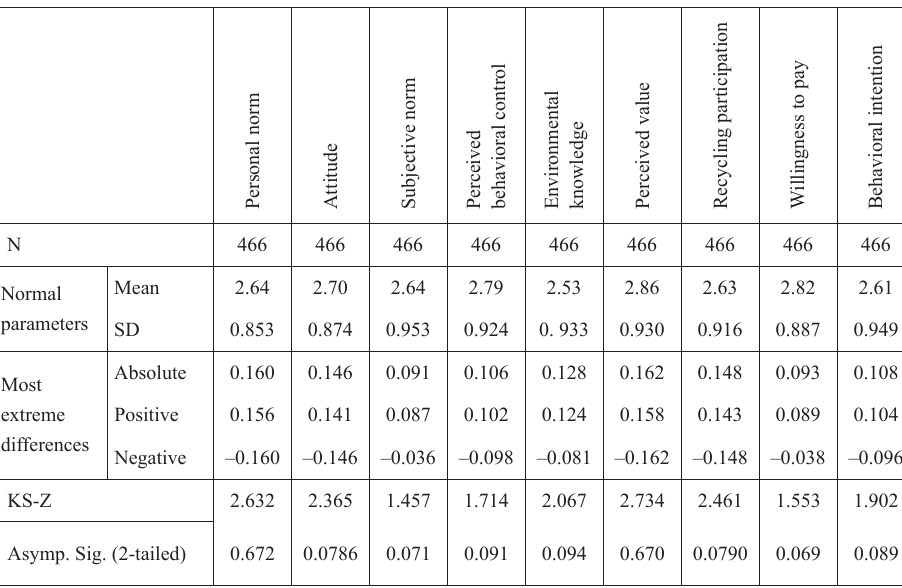
Table 3. Results of the one-sample Kolmogorov-Smirnov